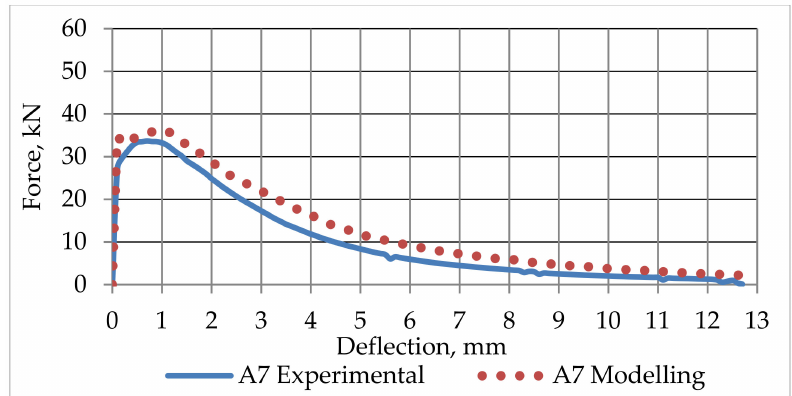
Figure 33. Experimental and modelling graphs for Group A7.